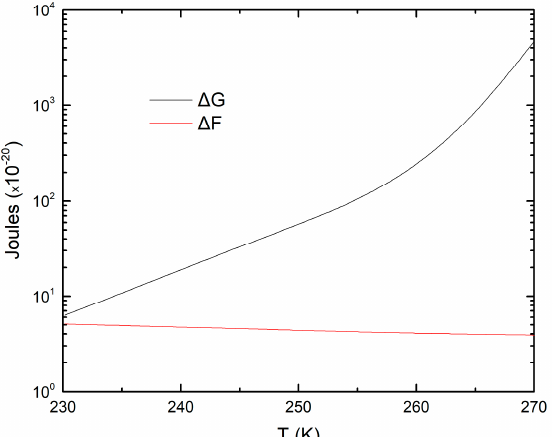
Figure 1. Variation of the Gibbs free energy ( ∆ G) and diffusion activation energy ( ∆ F) (Joules) with ambient temperature.